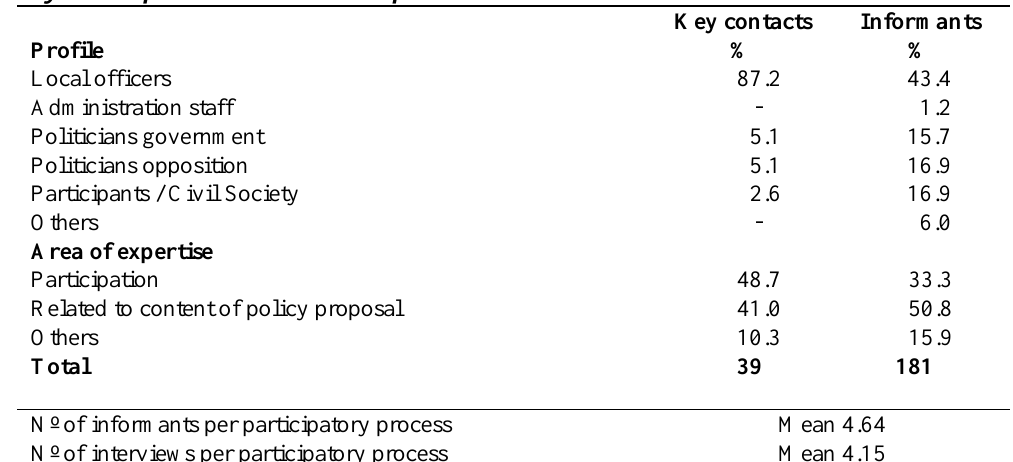
Key contact person and informants’ profile